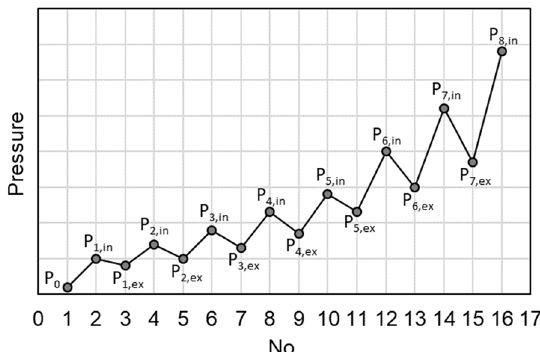
Figure 3. Illustration of the pressurization-depressurization cycling mercury intrusion porosimetry (PDC-MIP) test sequence.